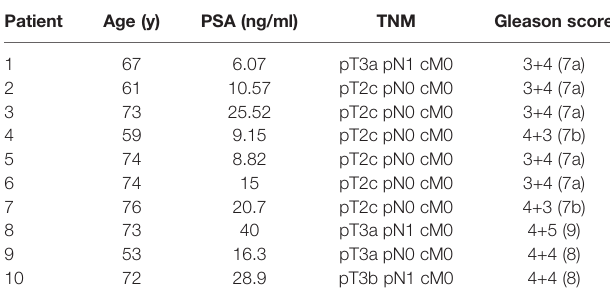
TABLE 1 | Patient characteristics.